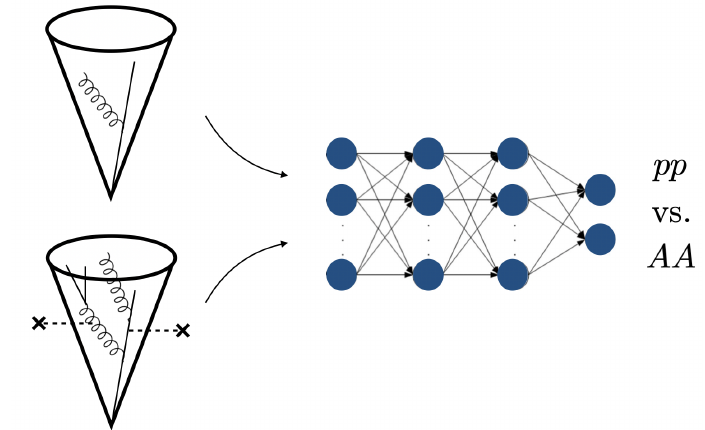
Figure 1 . Schematic illustration of jets in pp (left) and heavy-ion AA (right) collisions. Interactions with the QGP can lead to a modification of the jet substructure. By training a binary classifier, the machine learns the relevant information that distinguishes jets in pp and AA